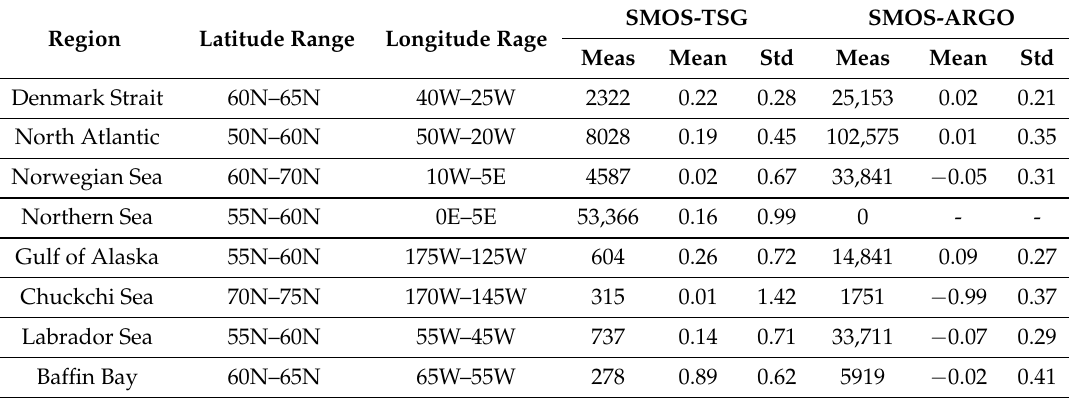
Table 3. Regional analysis on the differences between TSG and SMOS SSS (SMOS-TSG). Regional statistics of differences between SMOS and ARGO are also